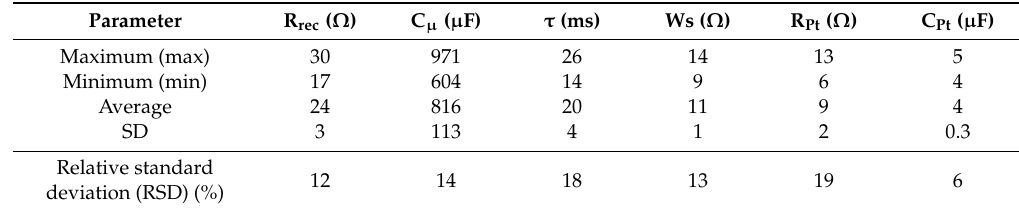
Table 4. Statistical data for the N719-based DSCs extracted from the fitted EIS parameters.